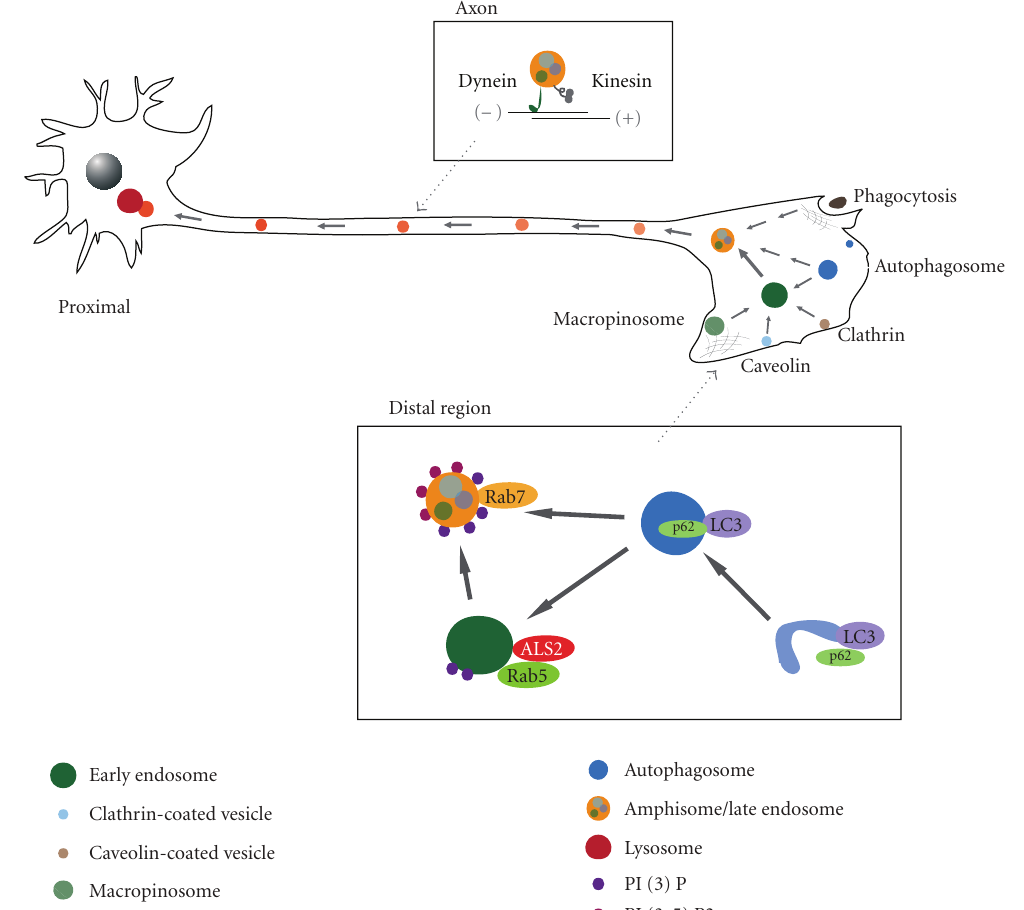
Figure 1: Endocytic tra ffi cking and the autophagy-endolysosomal system in